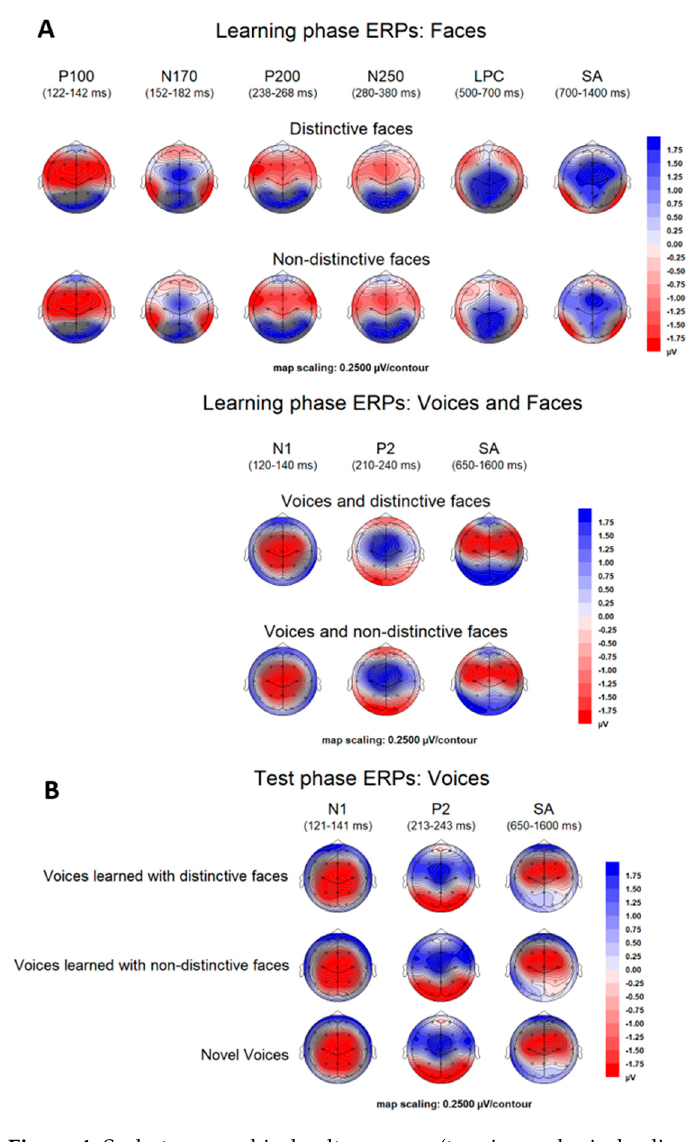
Figure 4. Scalp topographical voltage maps (topview, spherical spline interpolation, 110 ◦ equidistant projection) of ERPs in learning phases ( A ) , as elicited by distinctive and non − distinctive faces ( A , top ), or by voices combined with distinctive or non − distinctive faces ( A , bottom ), and ERPs in test phases ( B ) , as elicited by unimodal voices that had been originally learned with distinctive and non − distinctive faces.